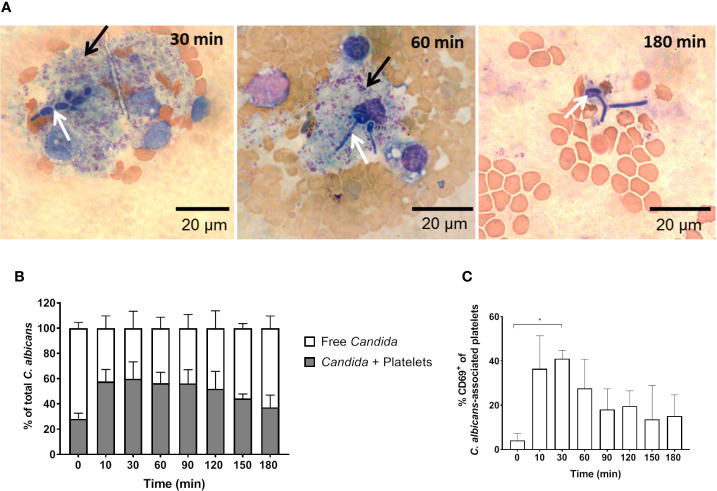

C. albicans-induced platelet activation and aggregation (A) Fungal interactions with platelets were visualized in blood smears of ex vivo infected murine whole blood after staining with Mai-Gruenwald- Giemsa. Aggregates of thrombocytes (black arrow) surround Candida (white arrow) mostly during the first hour of infection. Flow cytometry analysis shows (B) strong binding of C. albicans to platelets almost immediately after infection and (C) induced expression of CD69 on the surface of platelets. Asterisks indicate significant differences (p<0.05; 1-Way ANOVA and Holm-Sidak’s multiple comparison test to compare each infected time point to 0 min).